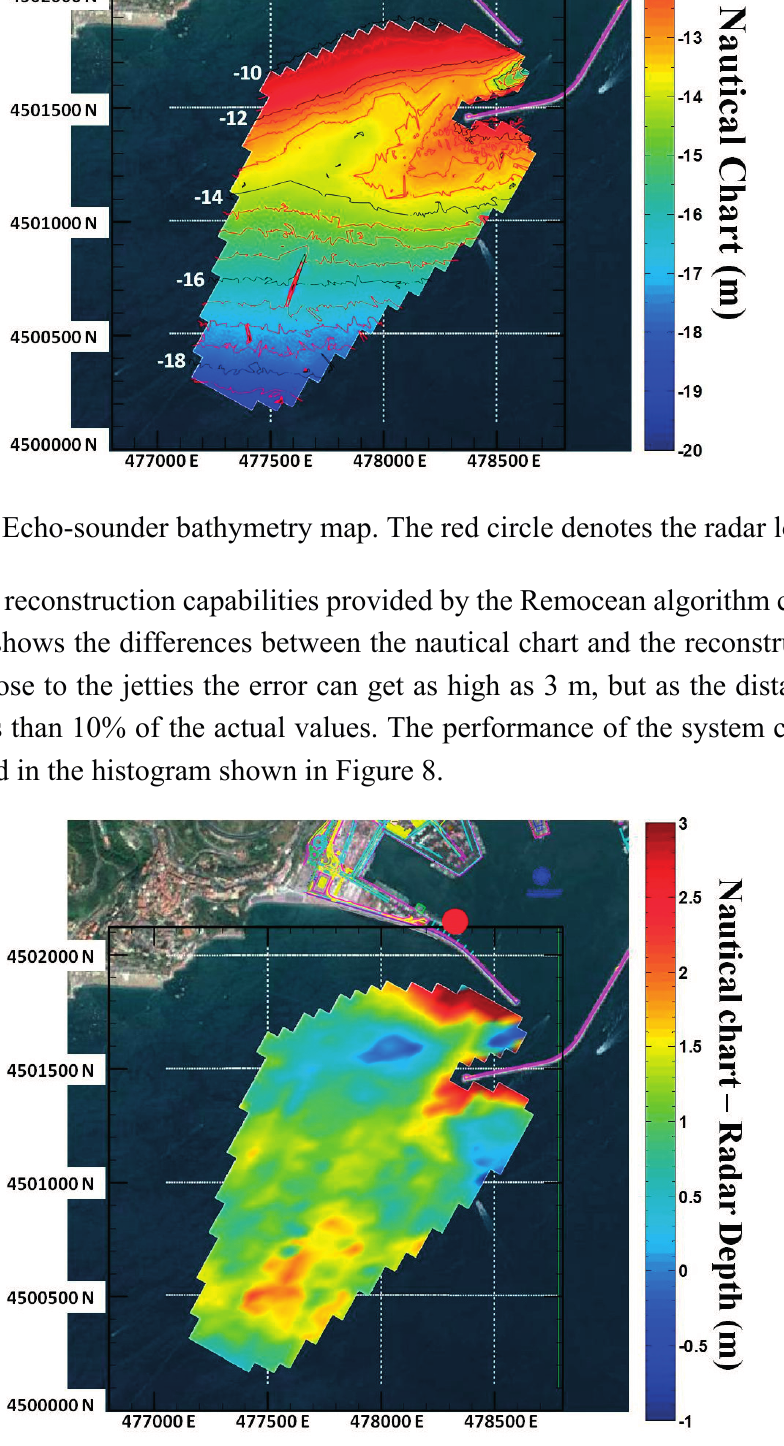
Figure 7. Map of differences between the echo sounder survey and the radar